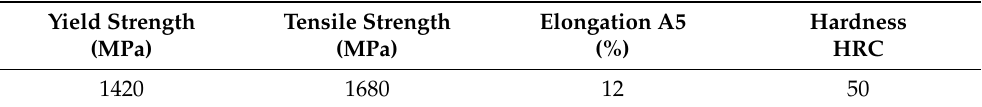
Table 2. Mechanical properties of the base material X38CrMoV5-1 by manufacturer.